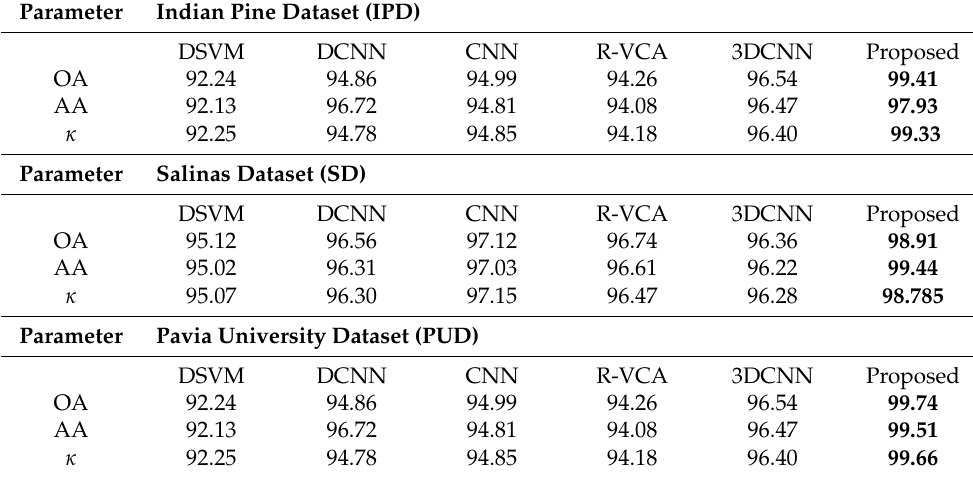
Table 2. Performance comparison of proposed framework with existing